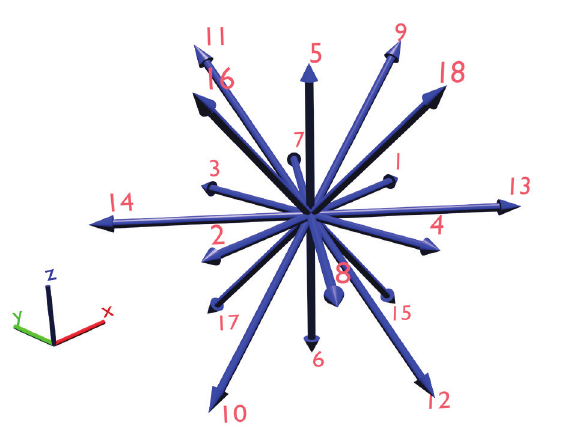
 e , with a  is not 0,0,0 e = 0